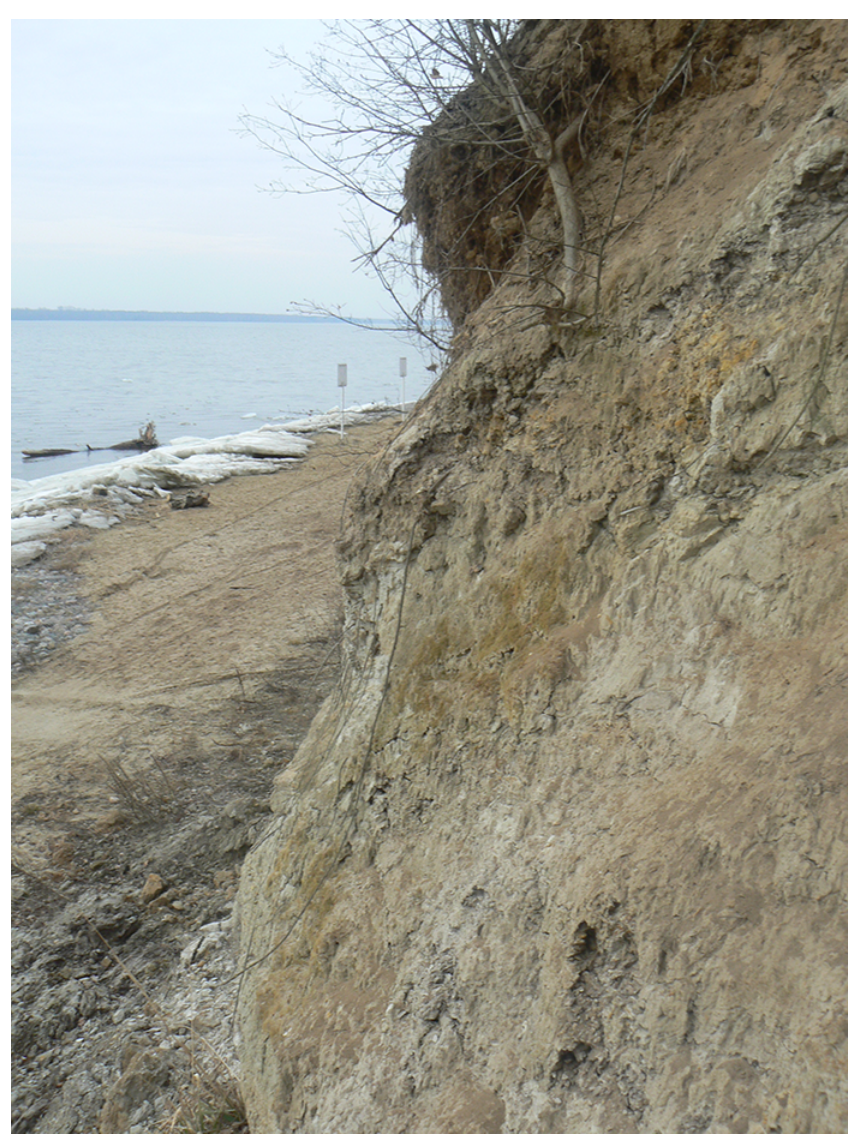
Figure 3 Habitat on the bank of river in Dobrzyń nad Wisłą (photo M. Szczepański, March 20,